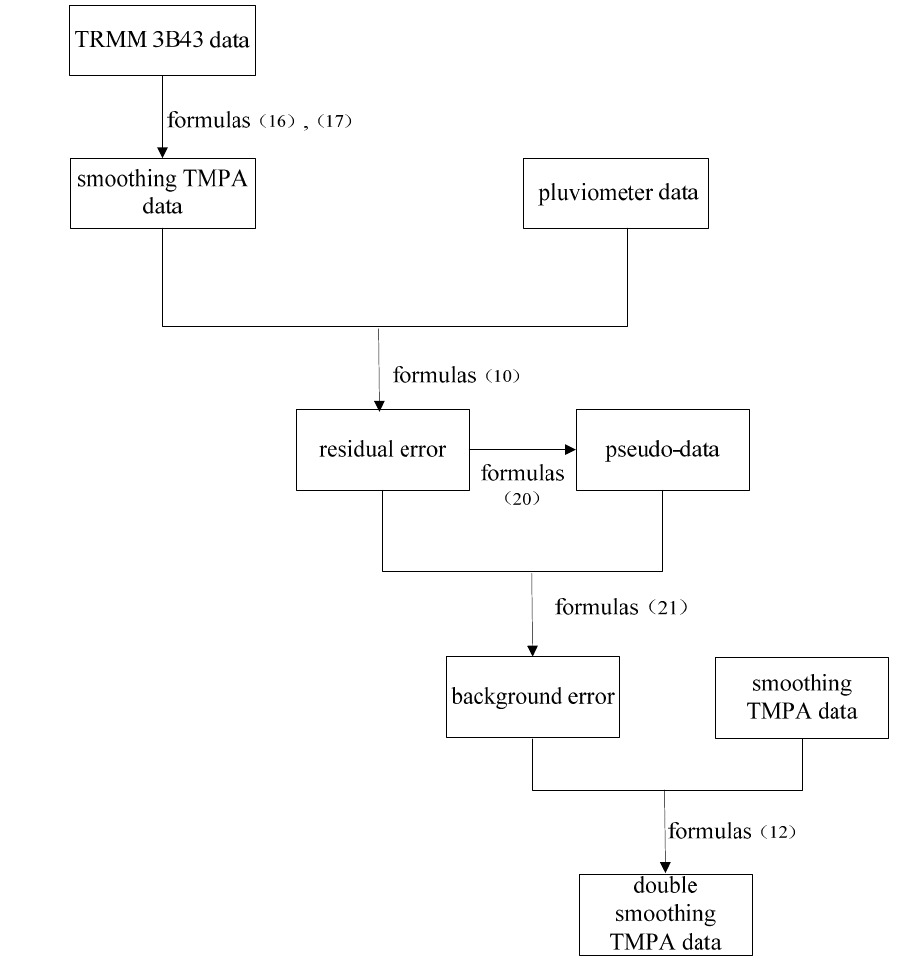
Figure 3. Fusion method flowchart of precipitation estimation based on a double-smoothing